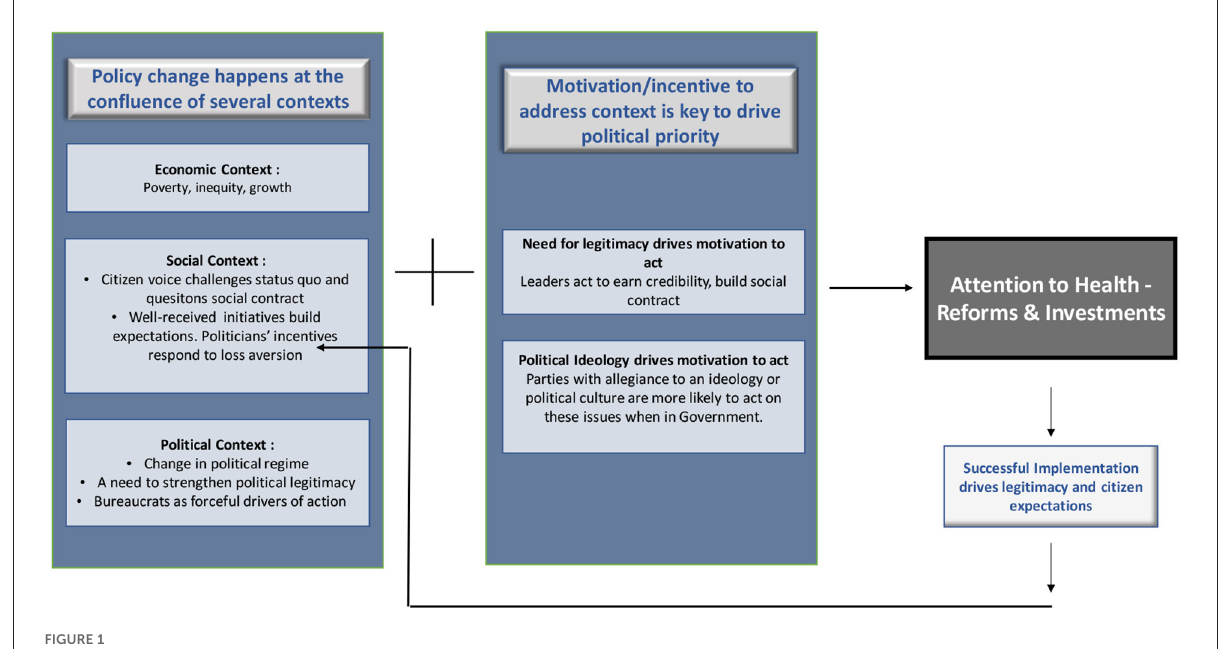
FIGURE1 Framework for political attention to